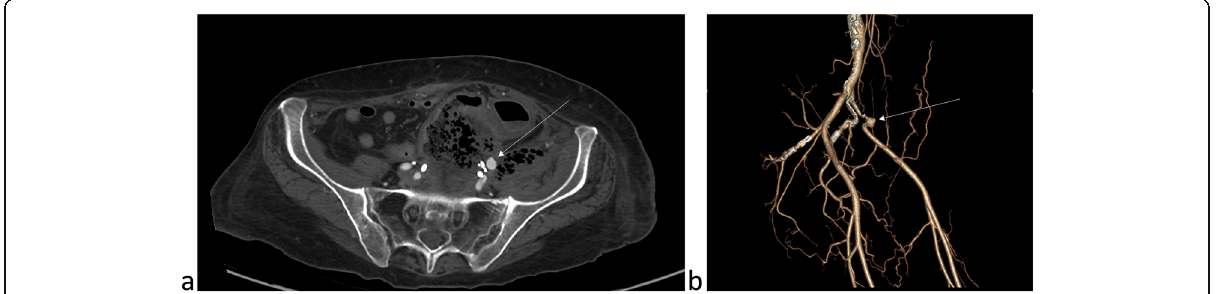
Fig. 1 An a axial cut of a Computed Tomography Angiogram and b a 3D reconstruction showing the pseudoaneurysm (arrow) arising from the left external iliac artery with narrowing of the vessel proximal and distal to the pseudoaneurysm appreciated on the 3D reconstruction, which are related to surgical